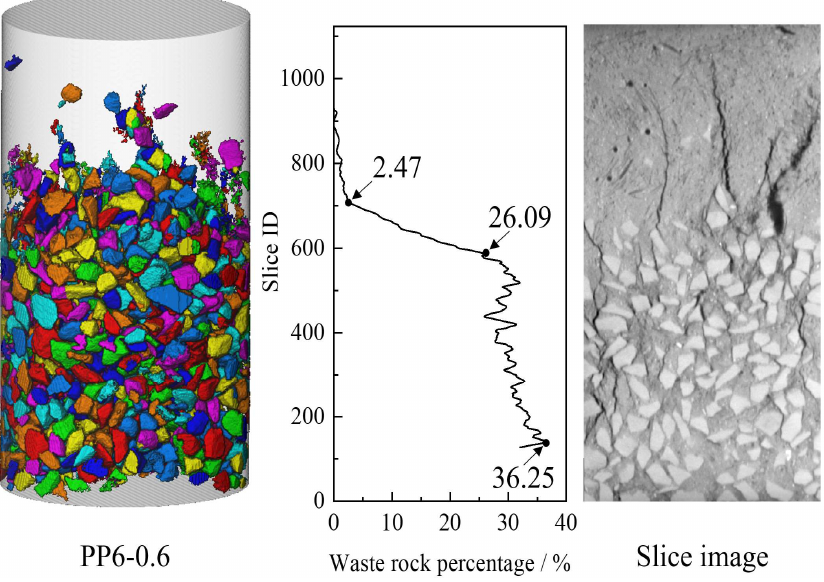
Figure 7. Distribution pattern of waste rock within PP6-0.6.